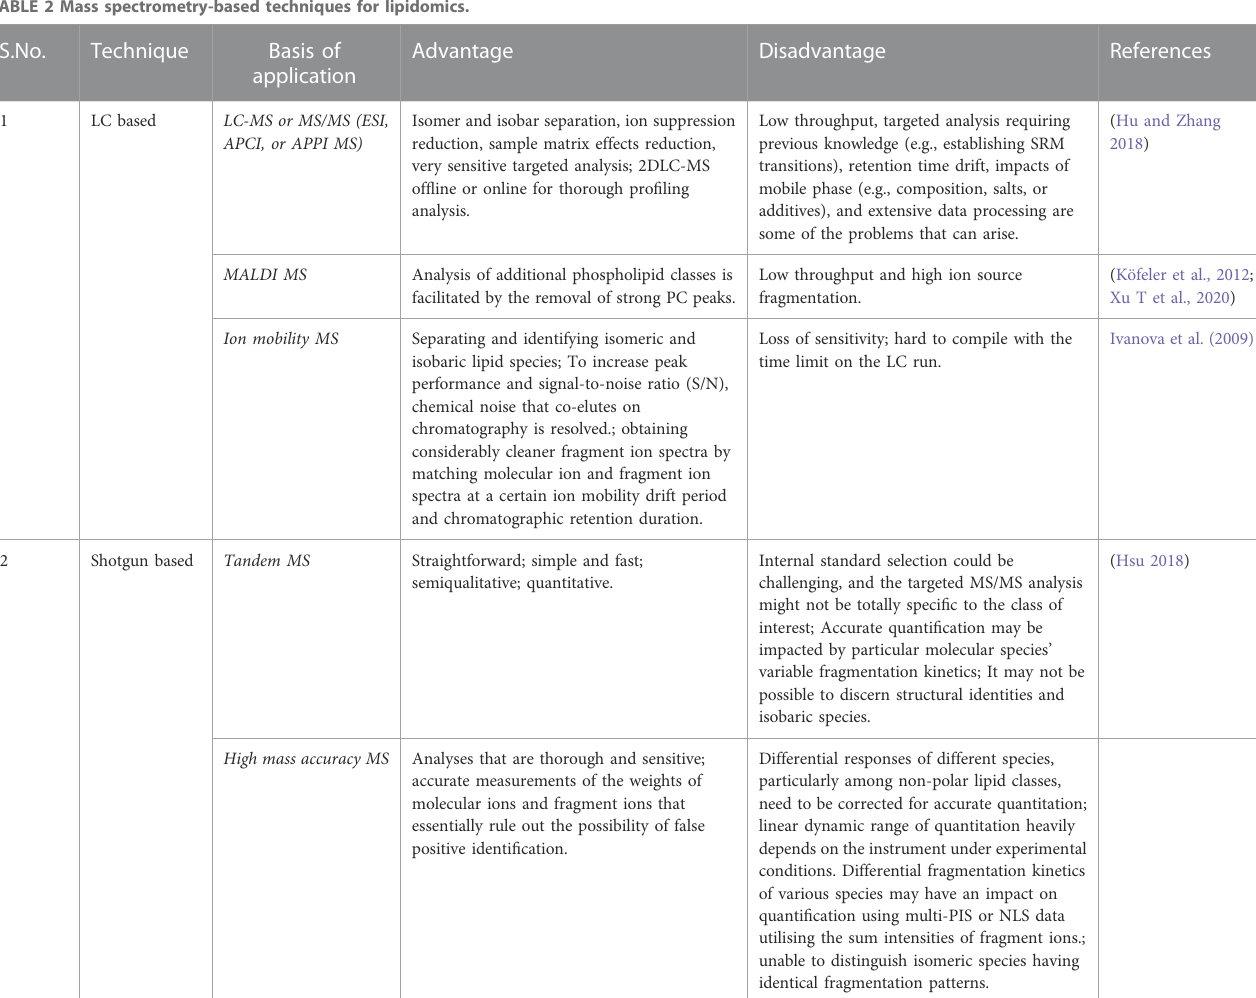
TABLE 2 Mass spectrometry-based techniques for